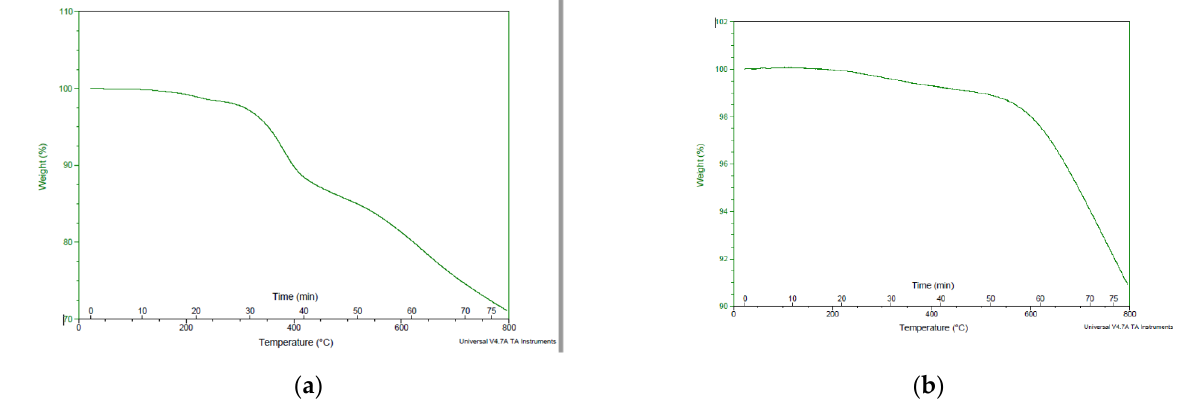
Figure 18. The TGA result for ( a ) CFRP ( b ) CF.